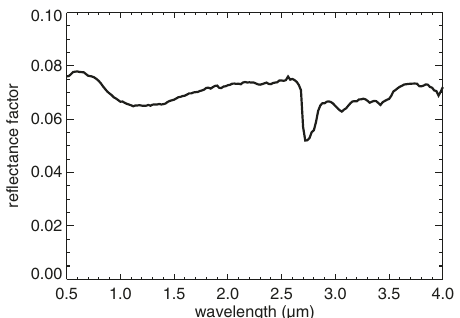
Fig. 10 Re fl ectance spectrum of the Ceres analogue material acquired at the standard geometry. The measurement uncertainty (standard deviation of 10 repeats) is smaller than the width of the drawn line over